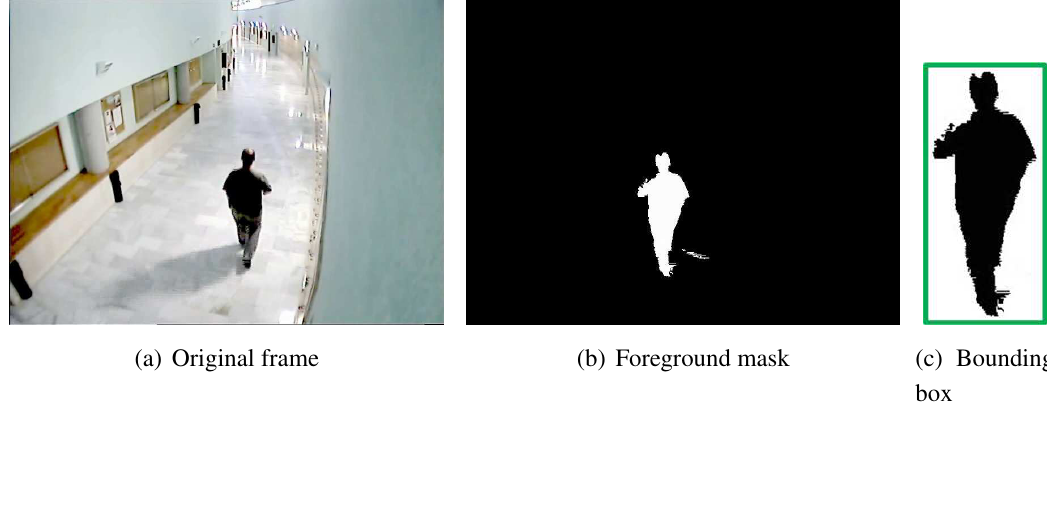
Table 1. First feature group: blob bounding box